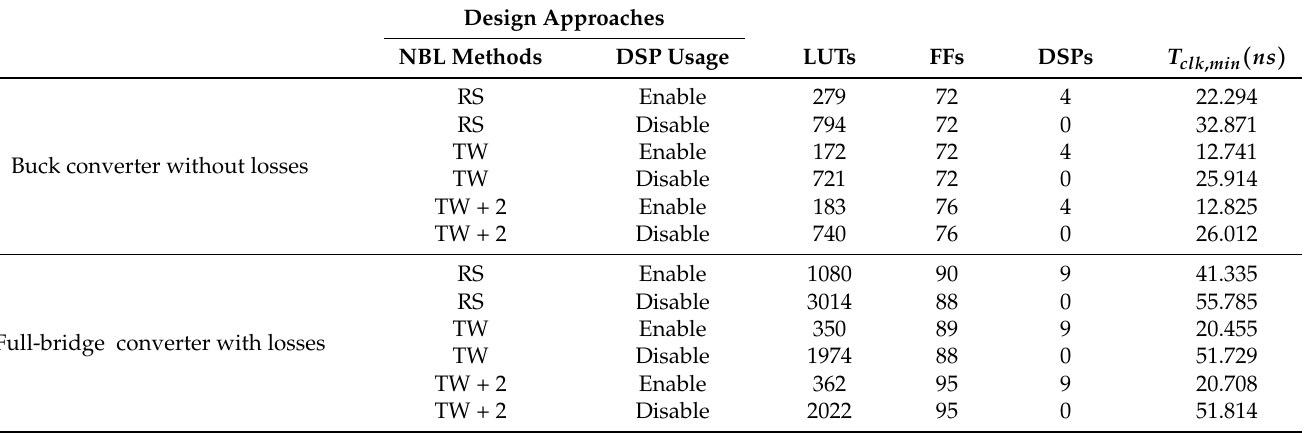
Table 3. VHDL-2008 synthesis results for fixed-point using Precision tool.